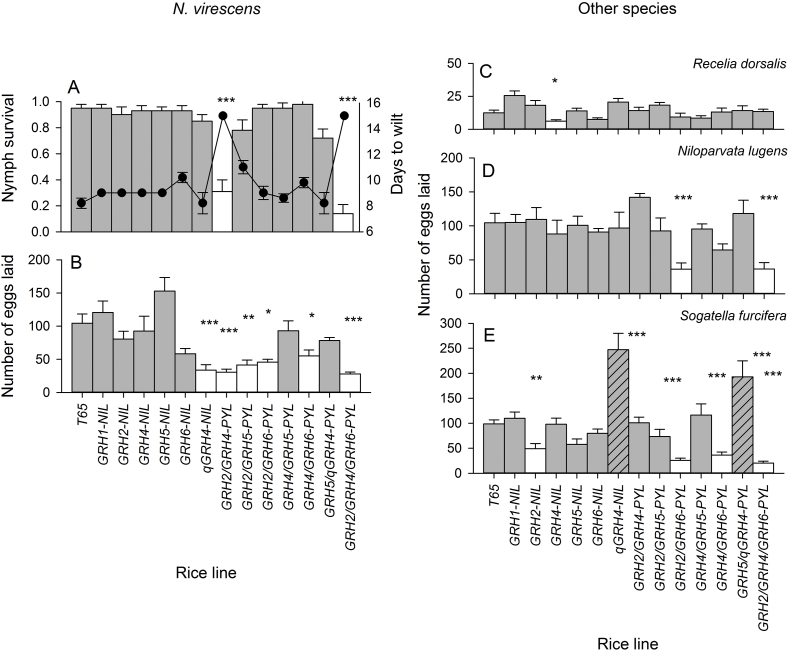
A) Proportion of nymphs surviving (bars) and number of days for 7 DAS plants to wilt (solid points) when infested with GLH nymphs and numbers of eggs laid by gravid female GLH (B), ZLH (C), BPH (D) and WBPH (E) on plants infested at 20 DAS. Standard errors are indicated (N = 6). Asterisks indicate significant reductions in herbivore fitness compared to T65 (Dunnett's tests: *** = P ≤ 0.001, ** = P ≤ 0.01, * = P ≤ 0.05). Resistant genotypes are indicated by white bars; cross-hatching in E indicates significant increases in egg laying (see Table S2A and S2B for further details).